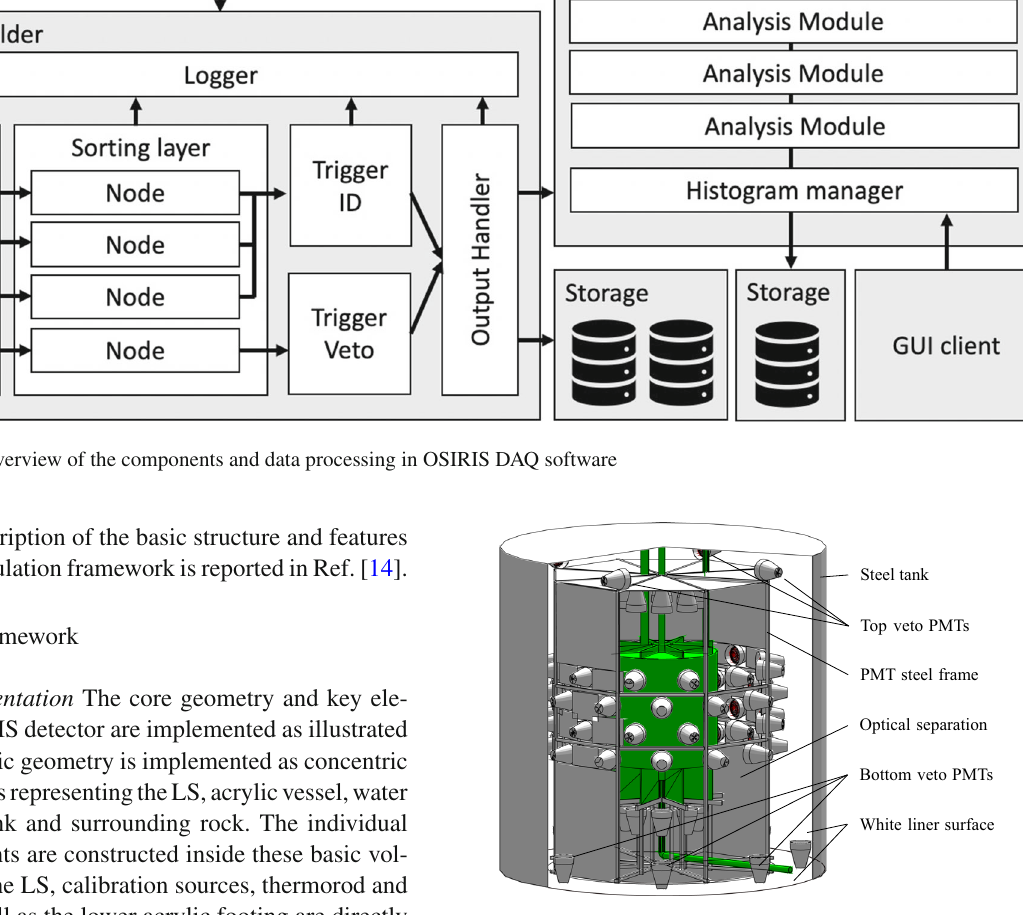
Fig. 14 Rendered depiction of the geometry implemented in simula- tion